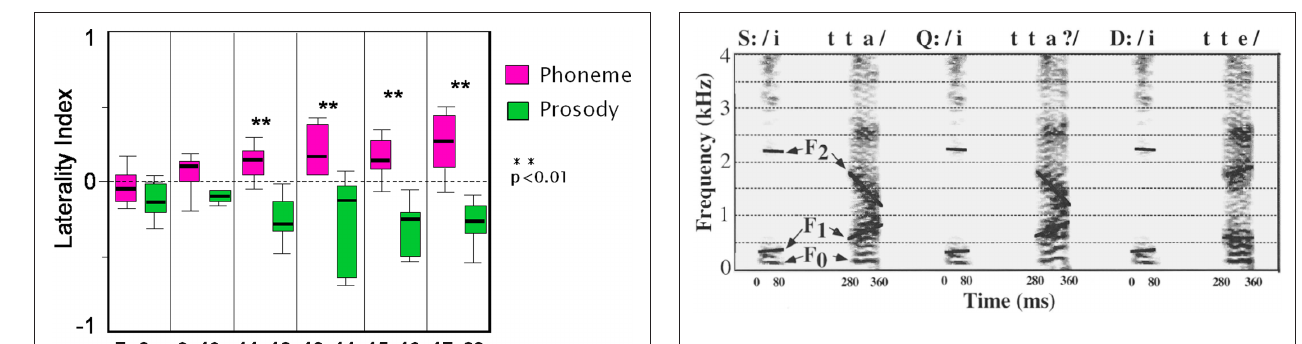
FIguRe 2 | Sound spectrograms for the three test words; a statement (S) /itta/, a question (Q) /itta?/ and a demand (D) /itte/ used in baseline and experimental conditions. All words were synthesized by changing the vocal pitch contour ( F 0) and the formant frequencies ( F 1 and F 2). These words consisted of a common initial /i/ vowel with a length of 80 ms, followed by a silent interval for / t /, and a final syllable. This is adapted from Imaizumi et al. (1998) with permission.